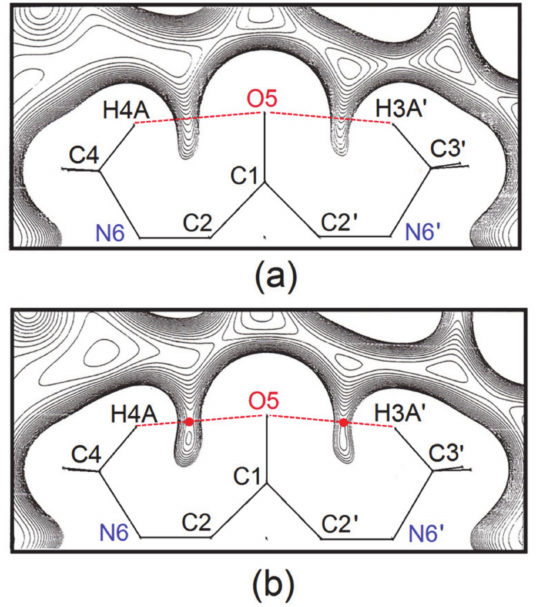
Figure 5. Total experimental charge density of SQ at T = 18(1) K in the main molecular plane. Level lines are drawn at steps of 0.01 e · Å –3 . ( a ) The multipole expansion includes poles up to l = 1 for ( a ), with l = 2 poles included on hydrogens. Now, (3, –1) saddle points are clearly detectable in the ρ ( r ) scalar field (red dots). Dashed red lines serve just as guides for the eye, to highlight relevant non-covalent